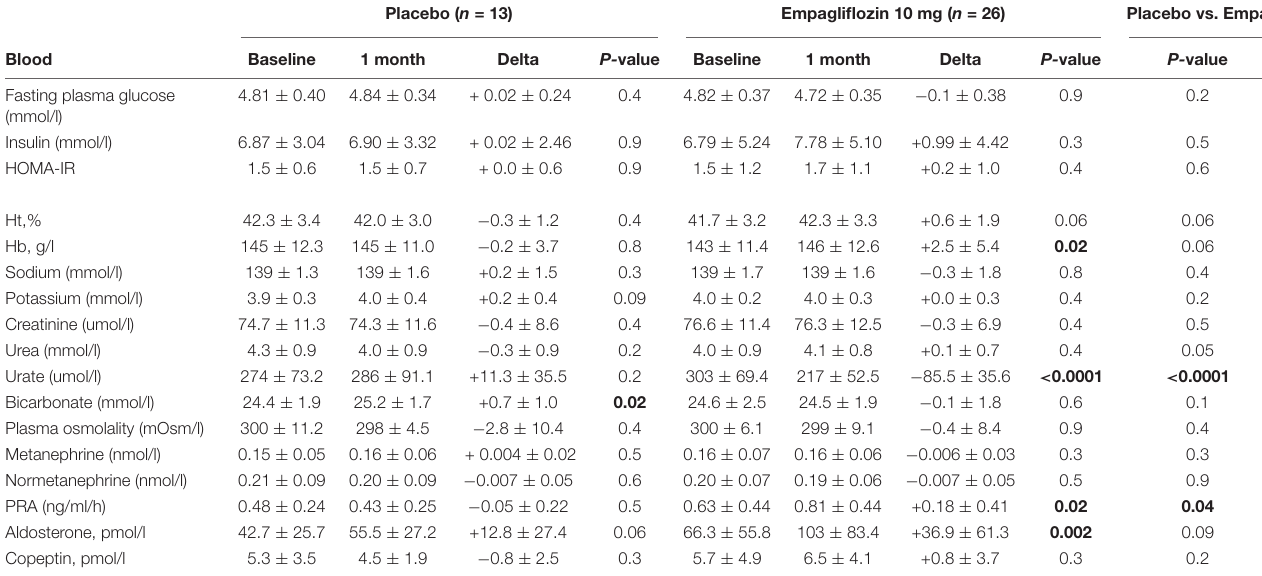
TABLE 2 | Biochemical and hormonal parameters measured at baseline and after 1 month of placebo or empagliflozin. Placebo ( n = 13) Empagliflozin 10 mg ( n = 26) Placebo vs. Empa